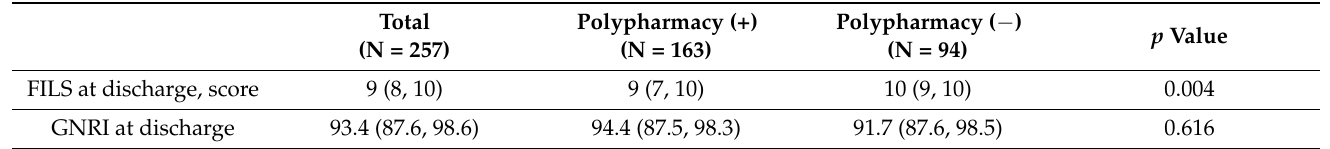
Table 3. Bivariate analysis of outcomes between two groups with and without polypharmacy.